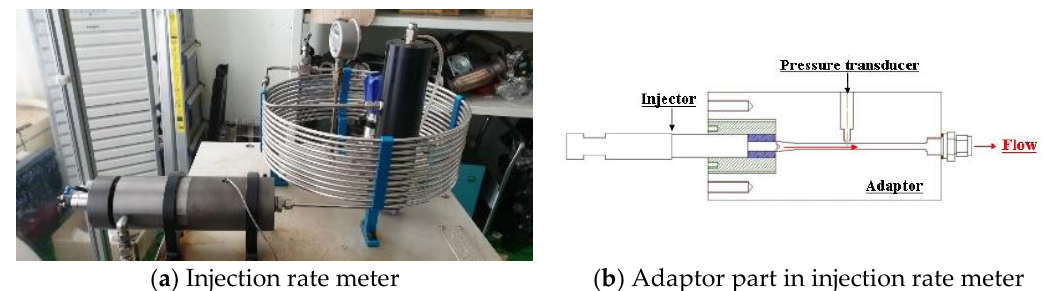
Figure 4. Experimental setup for injection rate measurement.